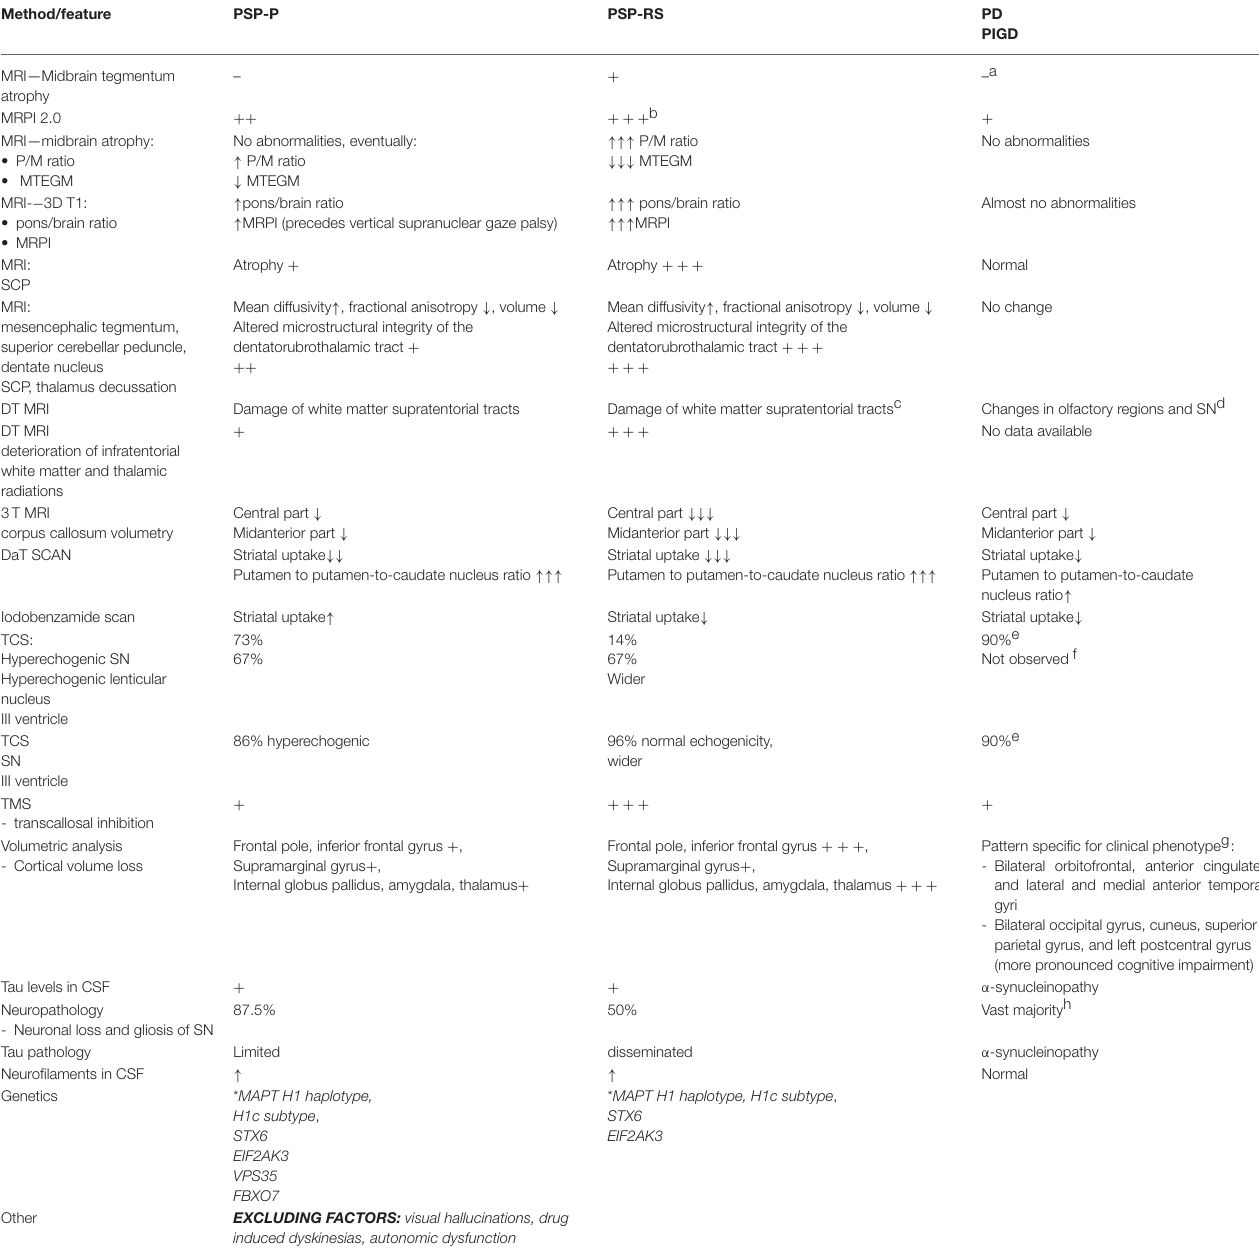
TABLE 1 | Comparison of PSP-P, PSP-RS, and PD features. Method/feature PSP-P PSP-RS PD